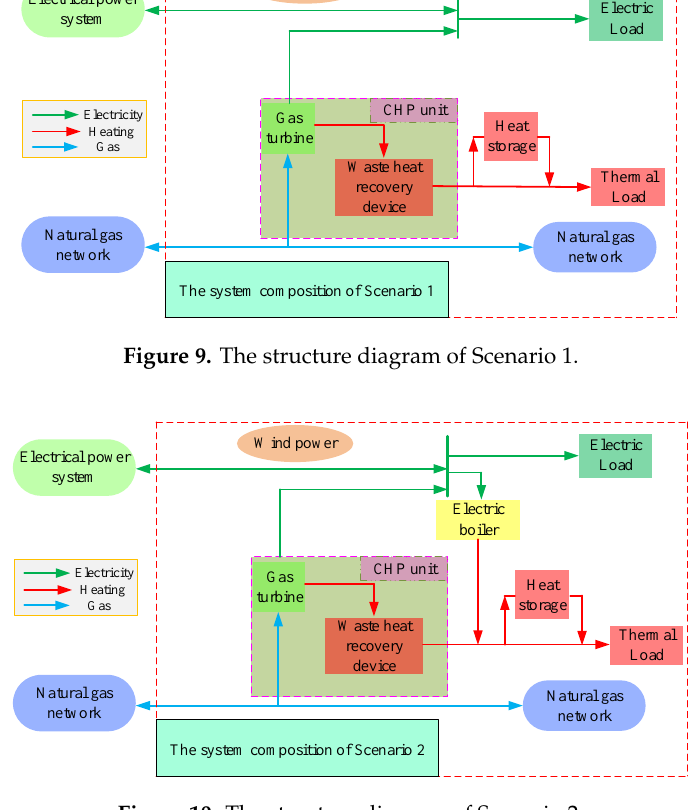
Figure 10. The structure diagram of Scenario